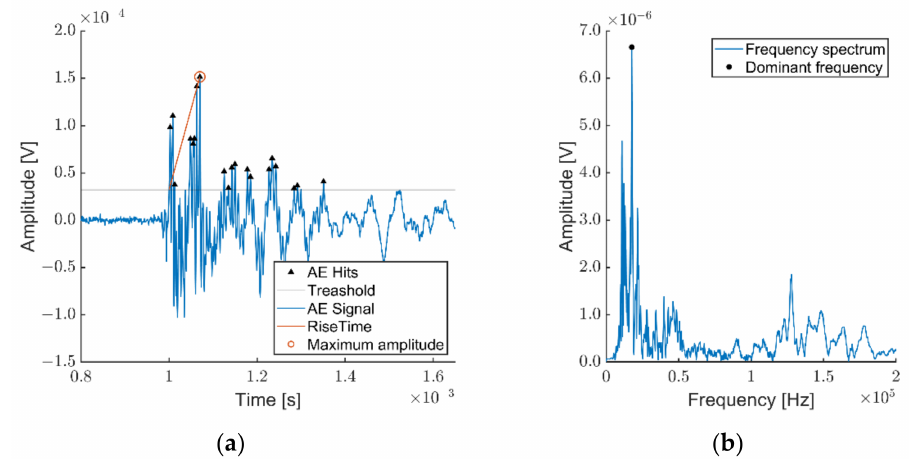
Figure 10. The depiction of the actual AE signal: ( a ) signal of the length of 32,824 samples, recorded during the sample frequency of 10 MHz, 20 present AE hits, rise time equal to 70 µ s, length of emission equal to 350.ms, maximum amplitude equal to 145 µ V; ( b ) depicted frequency spectrum with a marked dominant frequency equal to 17.6